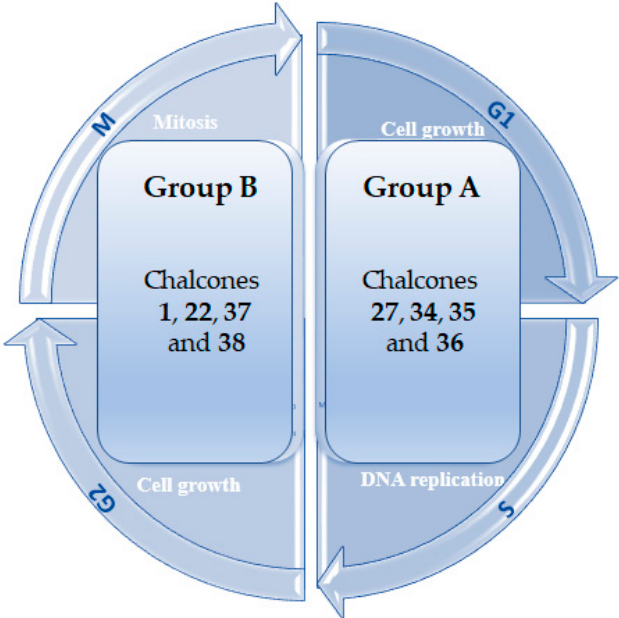
Figure 5. The effect of natural and synthetic chalcones on the cell cycle. Group A: Chalcones arrest the cell cycle at the G 1 /S phase, i.e., dimethyl cardamonin ( 27 ) [30], tetramethoxychalcone ( 34 ) [28], 2 ′ -hydroxy-2,3,4 ′ ,6 ′ -tetramethoxychalcone ( 35 ) [34], and tetrahydro-[1,2,4]triazolo[3,4-a]isoquinoline chalcones ( 36 ) [35]. Group B: Chalcones that arrest the cell cycle at the G 2 /M phase chalcone ( 1 ) [29], isoliquiritigenin ( 22 ) [36], (2 E )-3-(acridin-9-yl)-1-(2,6-dimethoxyphenyl)prop-2-en-1-one ( 37 ) [37], and quinazolinone-chalcone ( 38 ) [38].